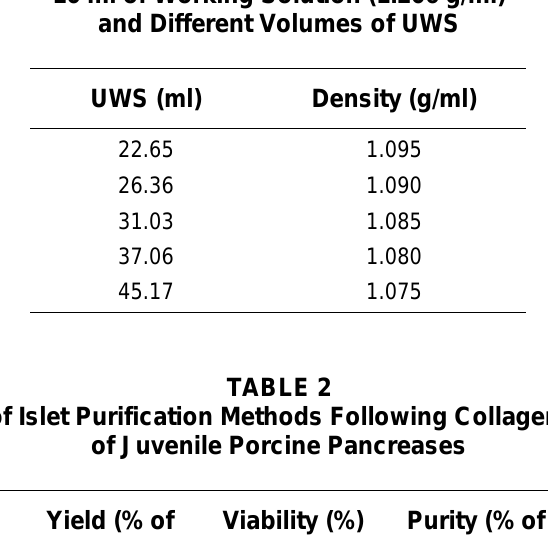
Density of Solutions Prepared from Mixing